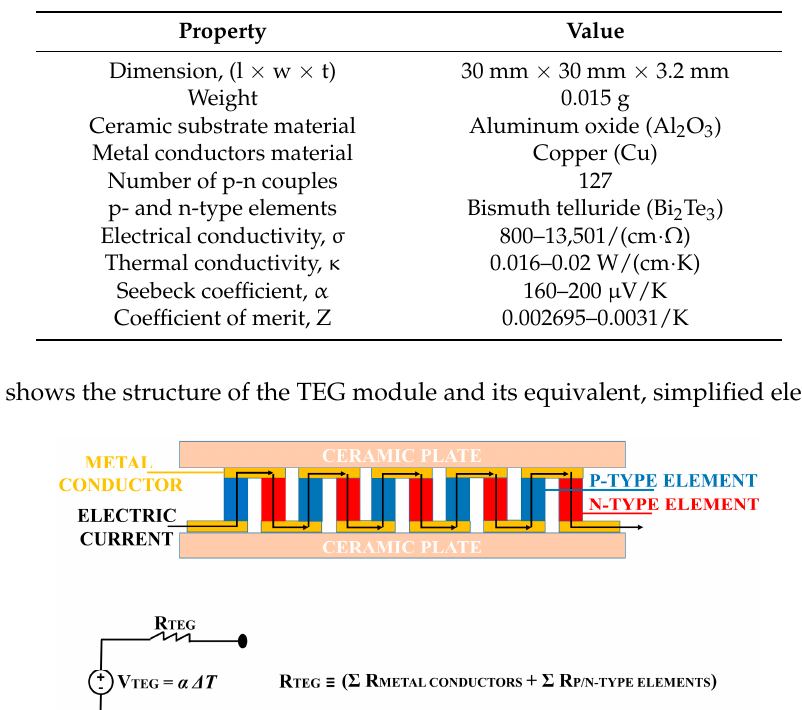
Table 2. Properties of the TES1-12704 module.